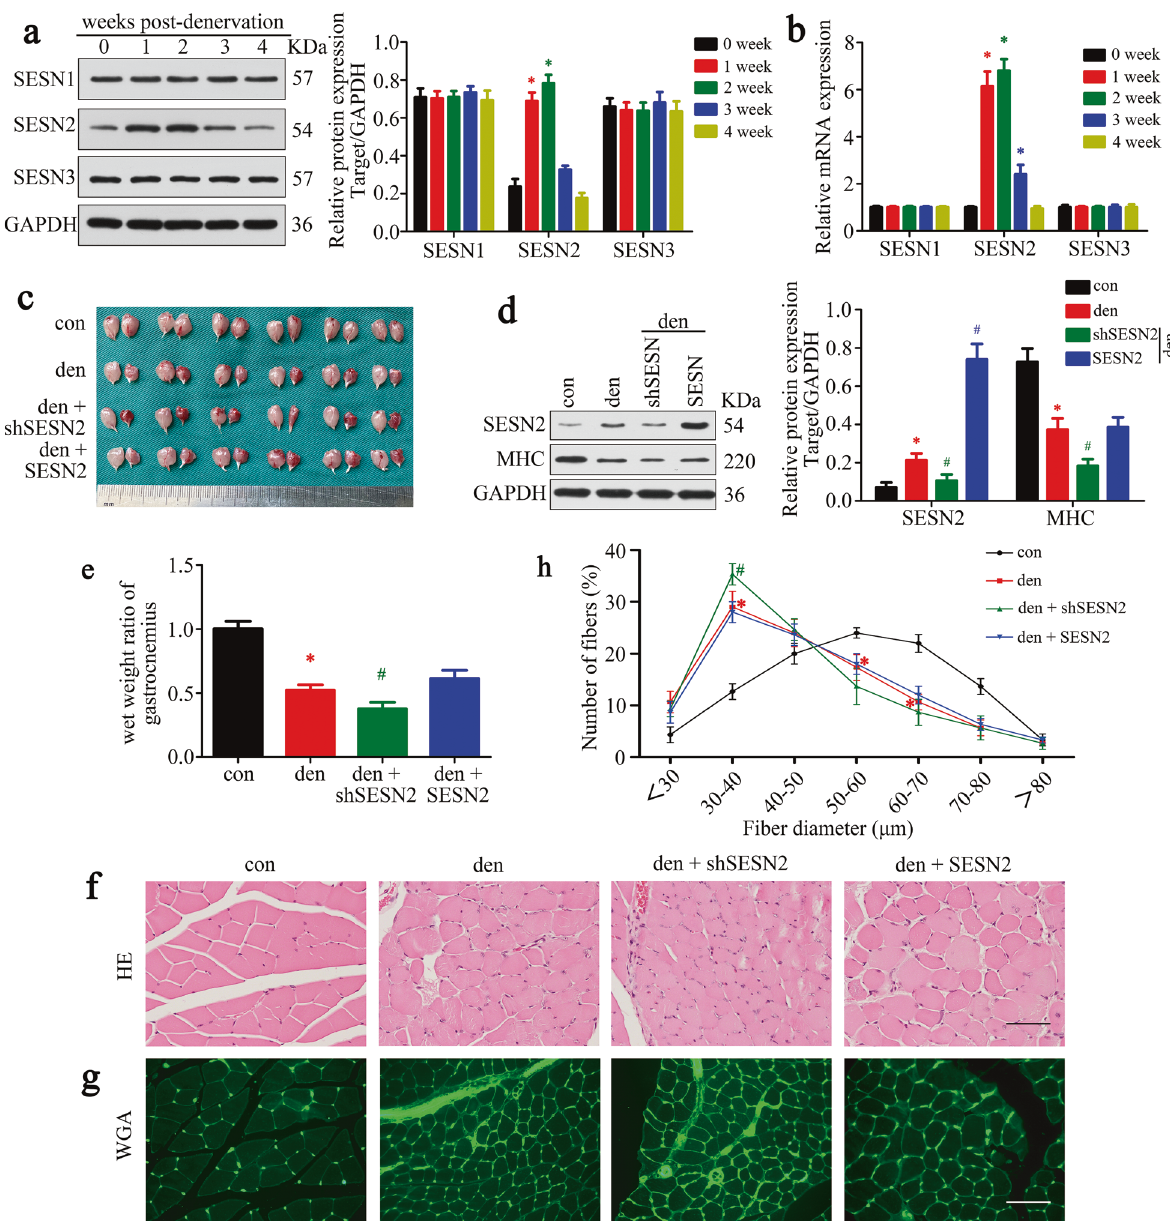
Fig. 2 Protective role of SESN2 against atrophy after denervation. a, b The contents of SESN1 – 3 were analyzed by western blot and RT-PCR. c GAS of different groups harvested 2 weeks post denervation. d Western blot analysis con fi rmed the expressions of SESN2 and MHC. e Wet- weight ratio of GAS in different groups. f Morphological observation of GAS muscles in different groups by H&E staining. Scale bar 50 μ m. g, h Quanti fi cation of muscle fi ber diameter by immuno fl uorescence staining of WGA. Scale bar 50 μ m. Data were presented as mean ± SD. n = 6. * P < 0.05 vs control (zero week or sham-operation group). # P < 0.05 vs denervation group. Den, denervation; Con, and was partially reversed by SESN2 knockdown (Fig. 6a). To investigate whether the AMPK/mTORC1 pathway was involved in the protective effect of SESN2 against rotenone-induced ERS, we analyzed the levels of ERS marker proteins in SESN2-knockdown cells under AICAR (an AMPK activator) and rapamycin (an allosteric inhibitor of mTORC1) treatment. Our results suggested that compared with the rotenone-alone treatment group, cells treated with both rotenone and AICAR displayed lower phosphorylation levels of mTORC1 and S6K. Further, treatment with AICAR exerted consistently protective effect on ER homeostasis, evidenced by lower levels of Bip, PERK phosphorylation, ATF4, and CHOP (Fig. 6b). Similarly, rapamycin treatment also inhibited S6K phosphor- ylation and attenuated ERS (Fig. 6c). In agreement with the in vitro